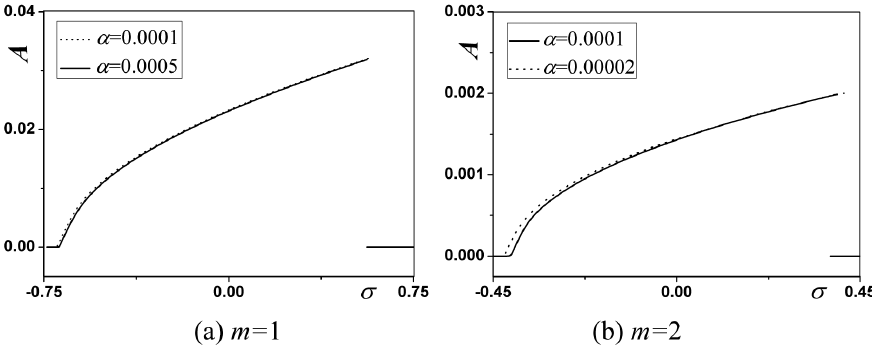
Fig. 11. Effects of the dynamic viscosity.